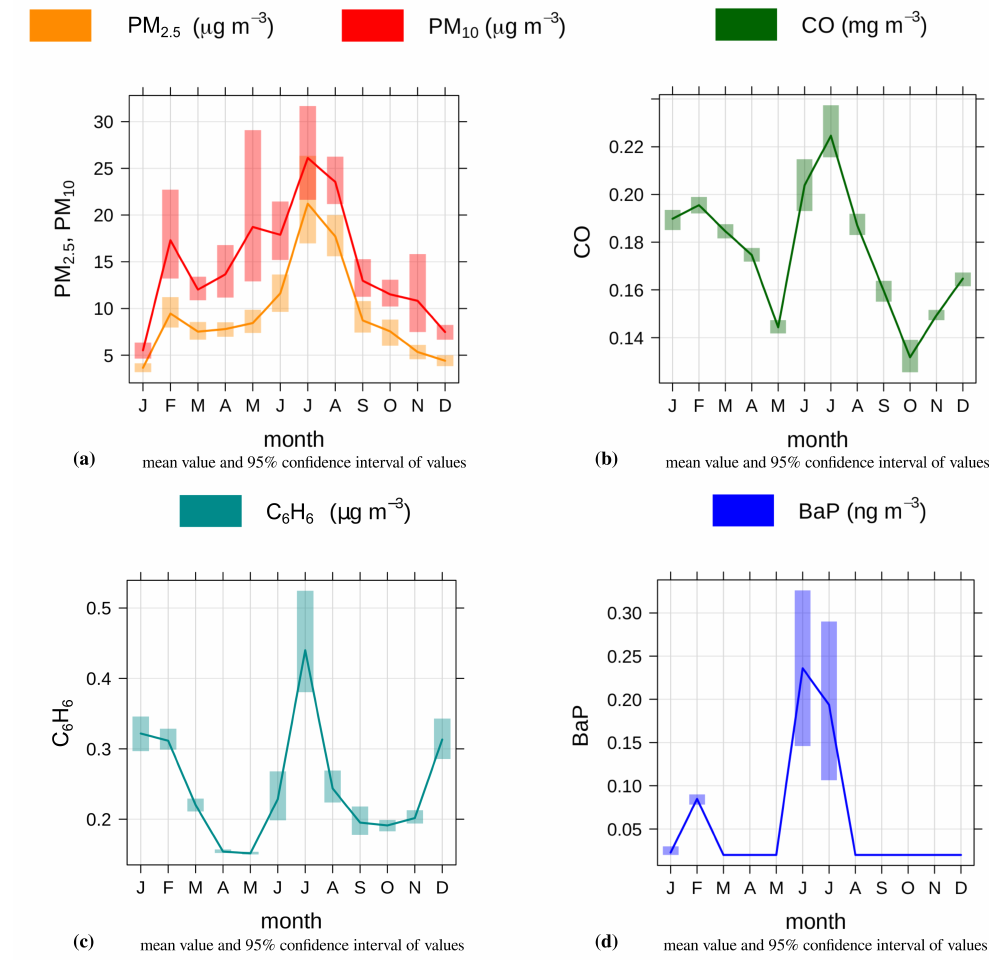
Figure 2. Monthly variation of ( a ) PM 2.5 and PM 10 , ( b ) CO, ( c ) C 6 H 6 , and ( d ) BaP recorded during 2017 at the rural regional background Mammola